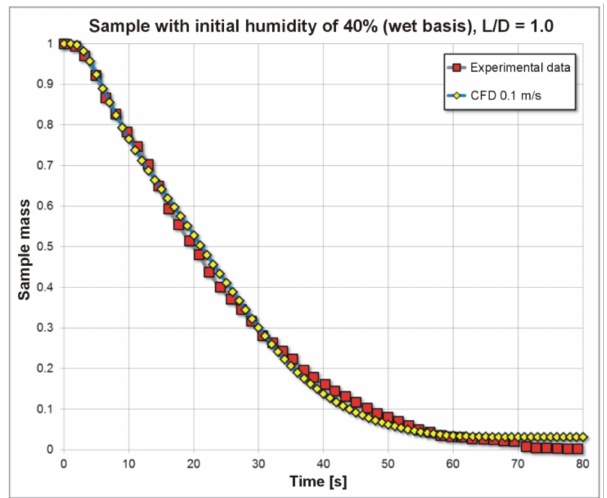
Figure 7. Comparison between simulated and experimental results [2] for the combustion of the sample with 40% initial moisture (wet basis) and L/D ratio = 1—3D